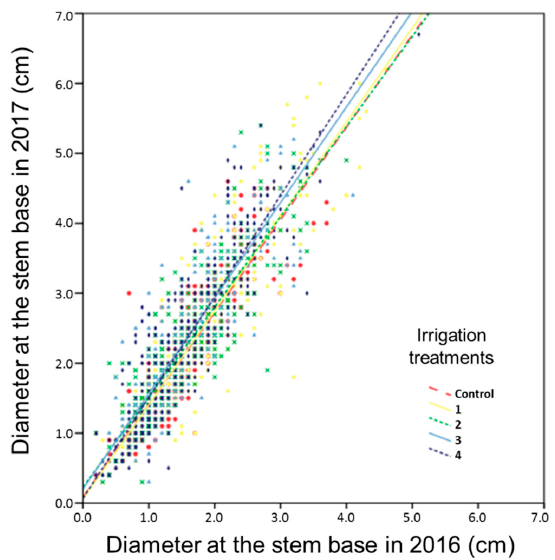
Figure 4. Linear relationship between initial (2016) and final (2017) diameter at the base, separated by irrigation treatments.